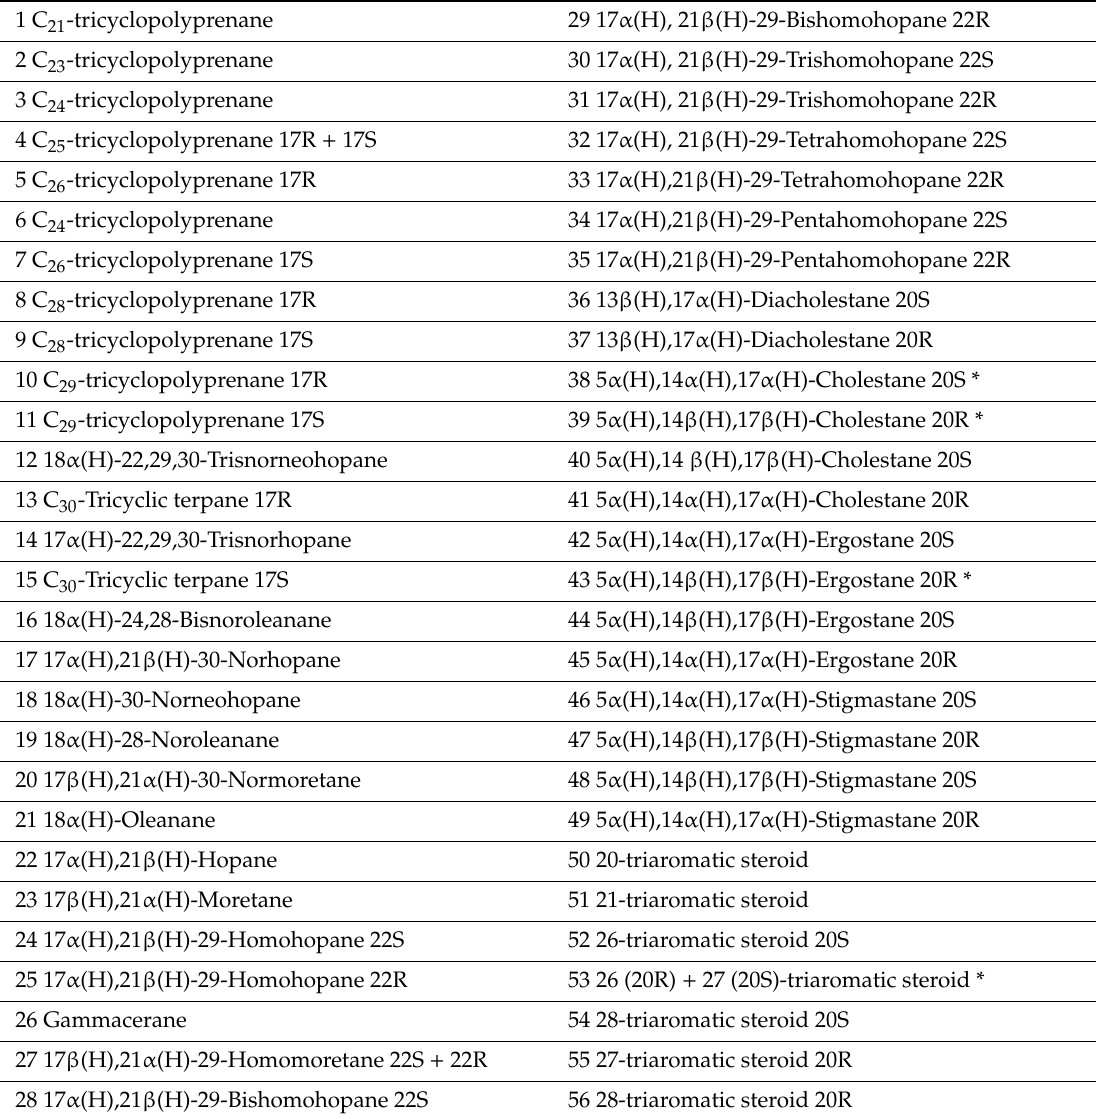
Table A1. Main biomarkers observed in the